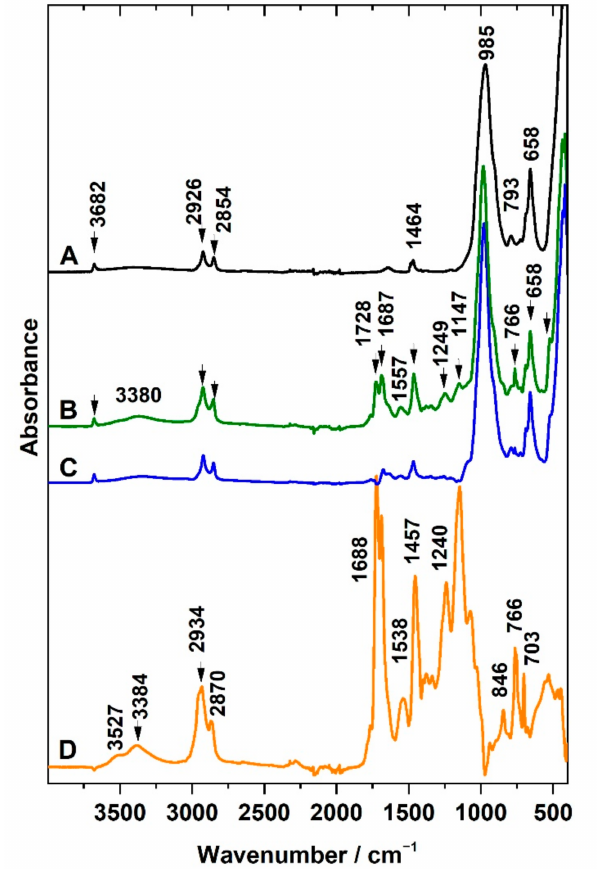
Figure 5. ATR spectra of organoclay OC ( A ), PUC membrane modified with an organoclay ( B ), and spectra of components calculated from the series of PUC-membranes spectra by MCR method ( C , D